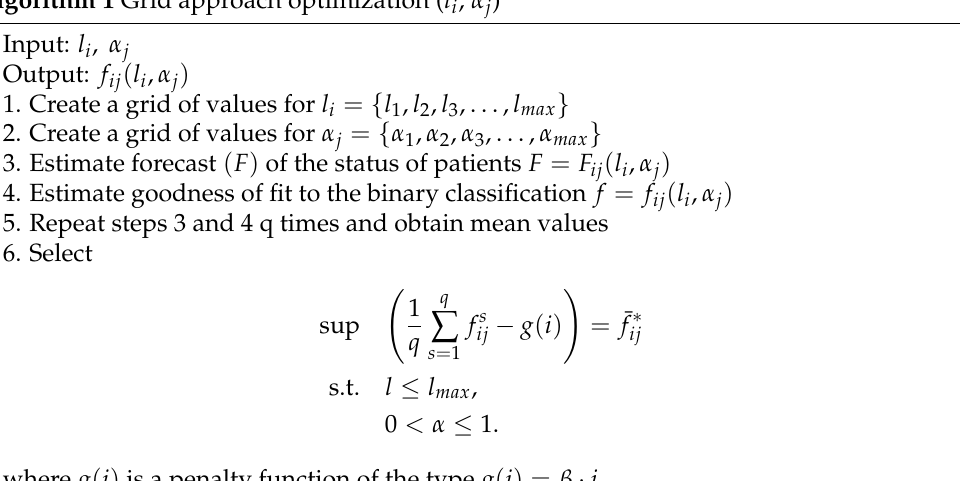
Algorithm 1 Grid approach optimization ( l i , α j